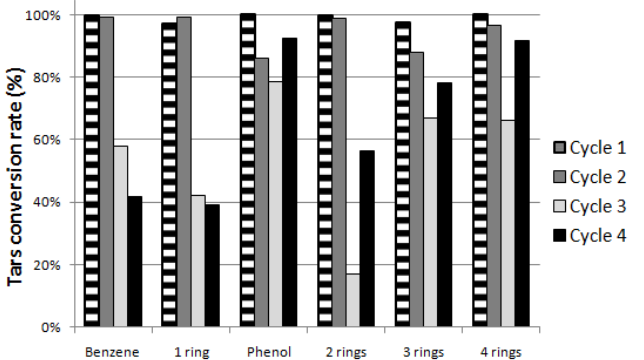
Figure 5. TAR conversion rate (%) for single TAR classes during the cycles.